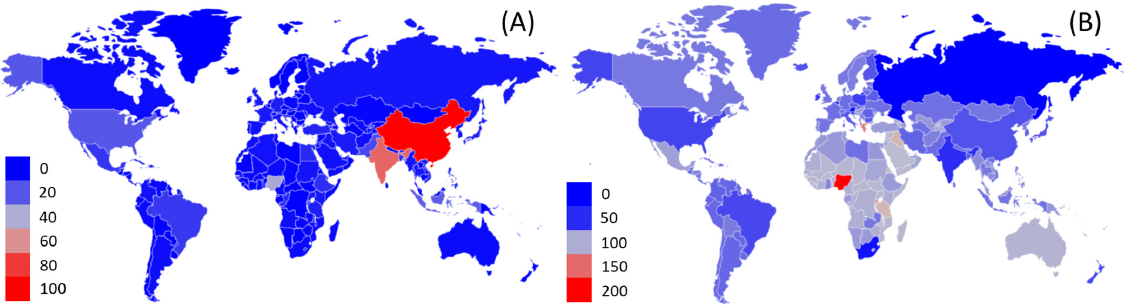
Figure 3. The estimates from different countries for ( A ) Household food waste estimate (MMT/year) and ( B ) Household food waste estimate (kg/capita/year). The countries with high estimates [Source: